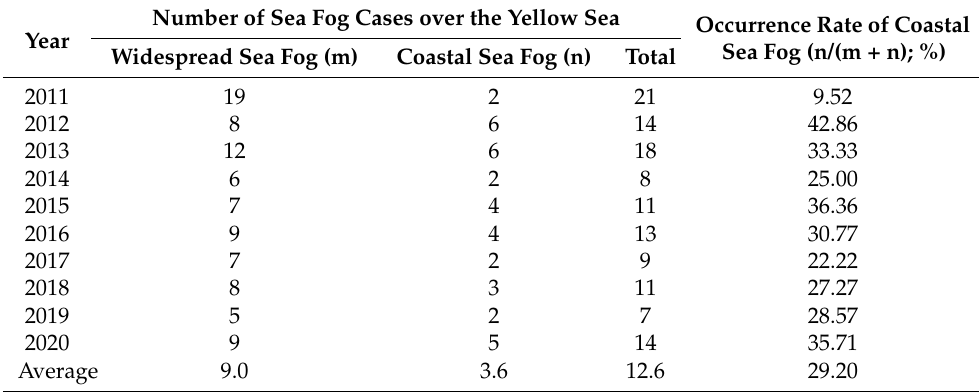
Table 1. Occurrence rate of coastal sea fog along the Shandong Peninsula (2011–2020). Number of Sea Fog Cases over the Yellow